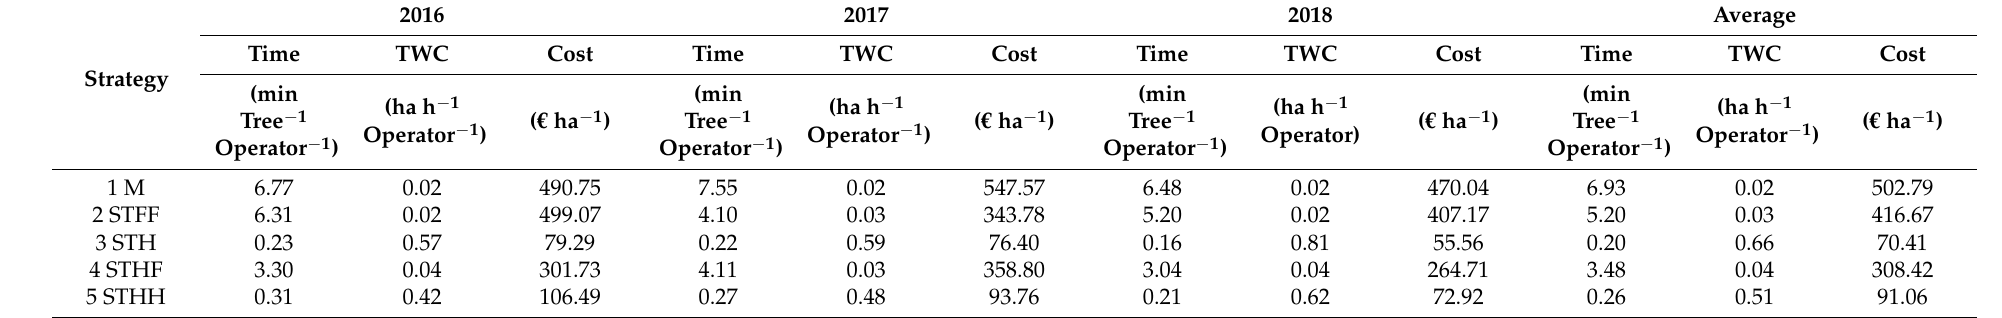
Table 9. Time spent to prune a tree (min/tree and operator), pruning theoretical working capacities (TWC 1 , ha h − 1 and operator), and cost 2 ( € ha − 1 ) for each strategy and year.